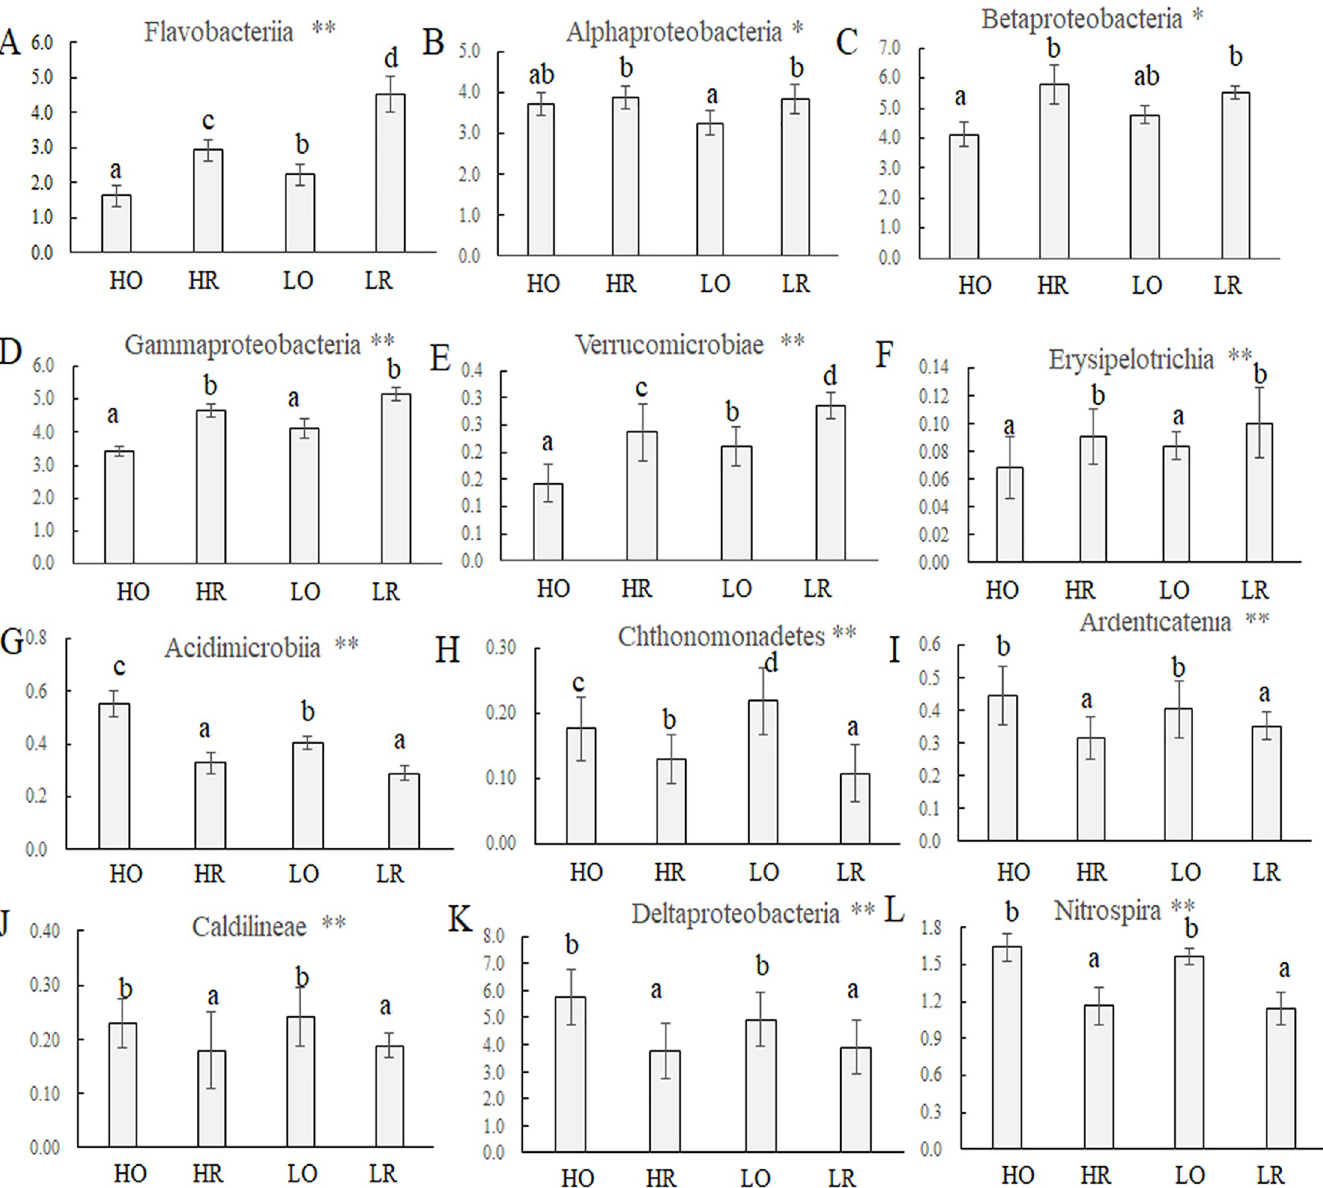
Fig 3. Average relative abundances (%) of classes affected by rhizosphere effects. The error bars indicate the standard deviations of the relative abundances between five replicate samples.